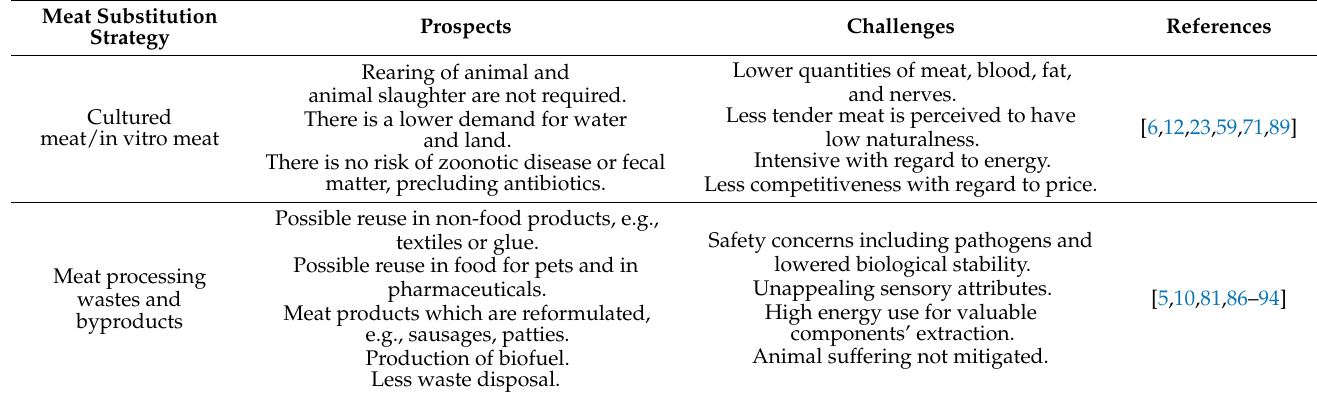
Table 3. Merits and demerits of cultured meat, meat wastes, and byproducts. Meat Substitution Prospects Challenges Strategy